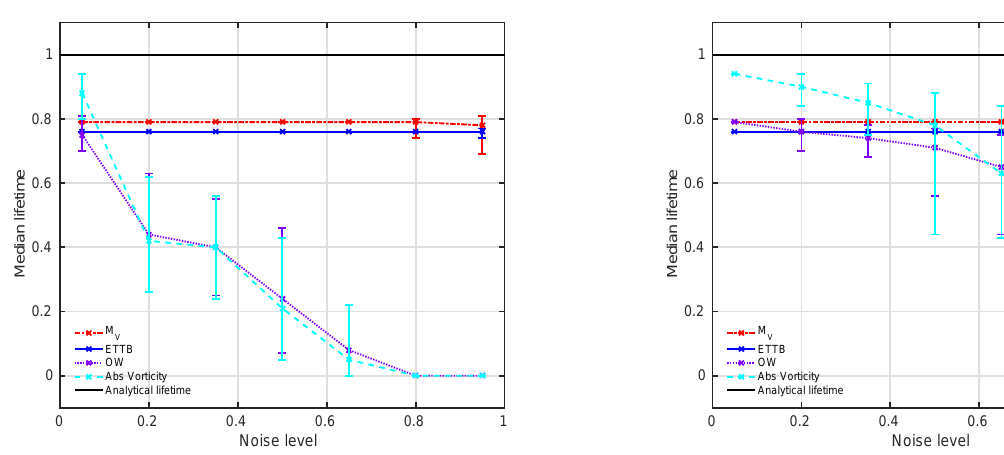
Figure 7. Measured median lifetime obtained by different methods (Okubo–Weiss (OW, violet), the modulus of vorticity (absVorticity, cyan), M V (red) and the eddy tracking tool box (ETTB, blue) by Nencioli et al. (2010)) depending on the noise level. The compu- tations have been performed in a velocity field mimicking a vortex street with type 1 noise (1000 noise realizations). The error bars in- dicate the whiskers of the distribution in the box plot (not shown here) corresponding to approximately ± 2.7 σ .